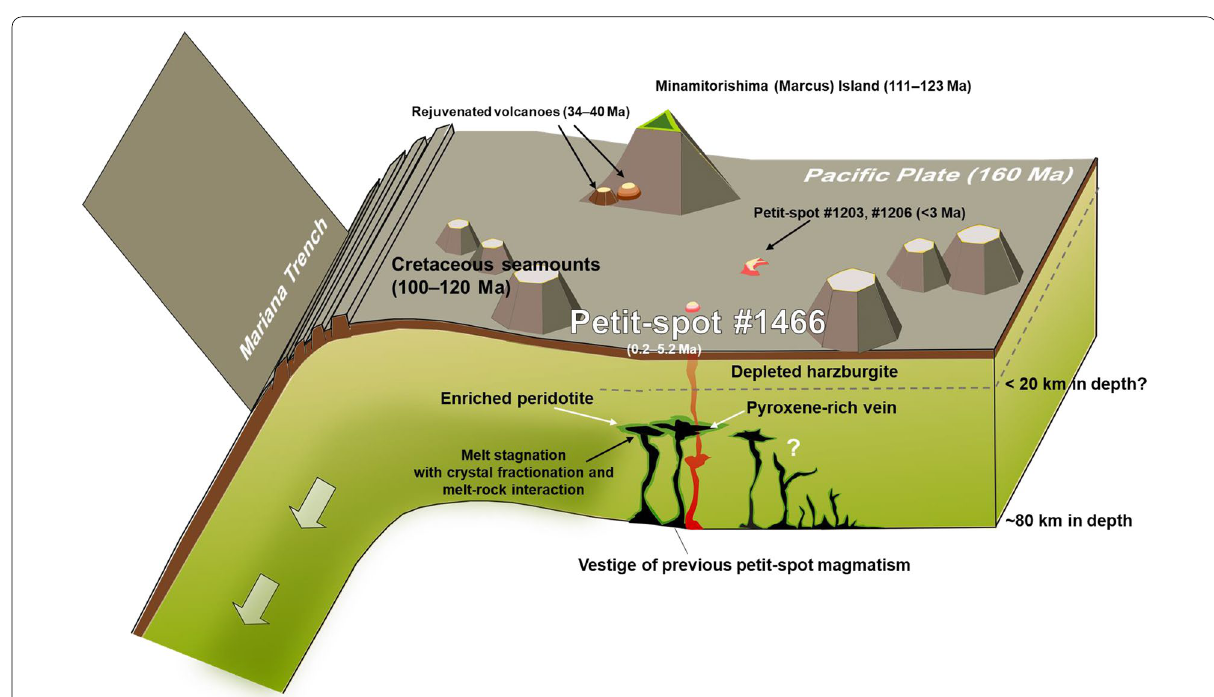
Fig. 10 Schematic model of the Pacific lithosphere at 160 Ma. The plate thickness of the study area (~ 80 km) is quoted from Kawakatsu et al. (2009). The formation ages of each volcanic edifice are quoted from Koppers et al. (2003) (Cretaceous seamounts), Hirano et al. (2019)